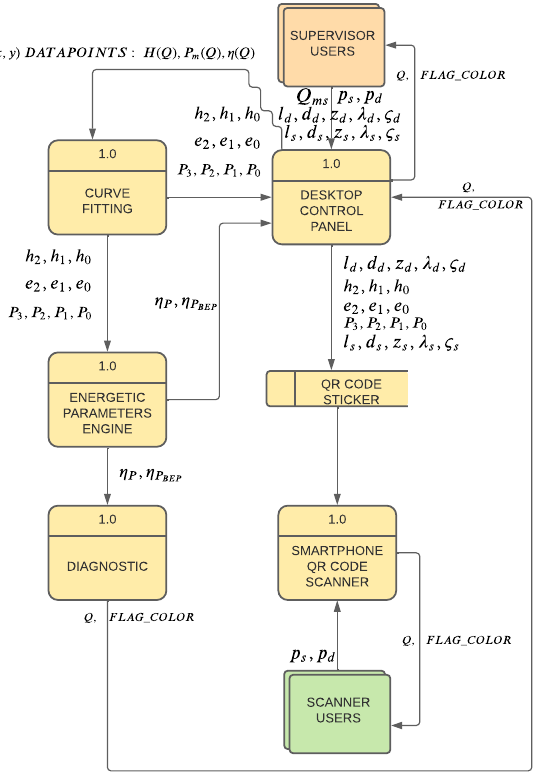
Figure 1. Diagram of the data flow in the software